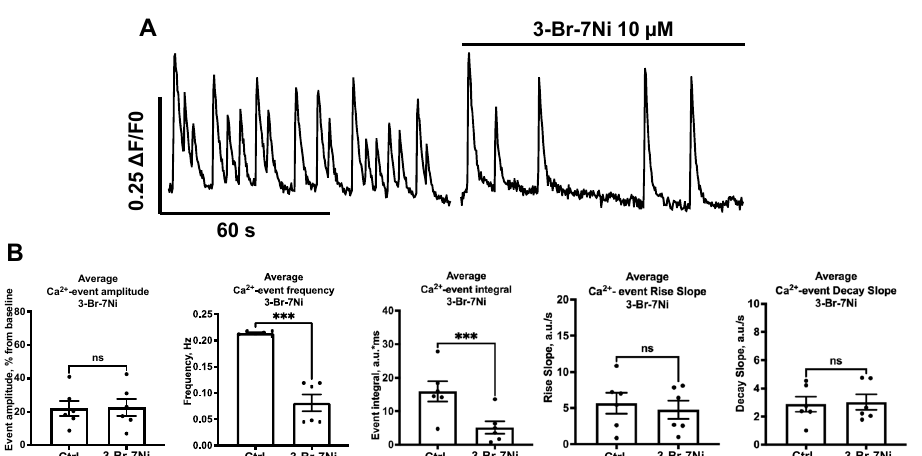
Figure 3. Influence of the 3-Br-7Ni blocker on SCEs. ( A ) Typical recording of the influence of 3-Br- 7Ni on SCEs. ( B ) Normalized amplitude (not significant), frequency ( p *** = 0.001), integral ( p *** = 0.0009), rise slope (not significant) and decay slope (not significant) for these influences are shown. Unlike 3-Br-7Ni, L-NNA significantly decreased the average amplitude of events (Figure 4B, n = 5, 38.70 ± 3.20 vs. 19.33 ± 4.65%, p = 0.026). The average frequency of events also decreased (Figure 5B, n = 5, 0.14 ± 0.01 vs. 0.11 ± 0.01 Hz, p = 0.0001). The calcium integral significantly decreased and was very close to that of 3-Br-7Ni (Figure 4B, n = 5, 15.9 ± 2.5 vs. 5.1 ± 1.7 a.u.*ms, p =0.0091). The rise slope (Figure 4B, n = 5, 11.20 ± 0.9 vs. 6.2 ± 1.1 a.u./s, p = 0.0088) and decay slope (Figure 4B, n = 5, 4.7 ± 0.6 vs. 3.3 ± 0.4 a.u./s, p = 0.033) of the calcium events significantly decreased with L-NNA, indicating changes in [Ca 2+ ] in dynamics.